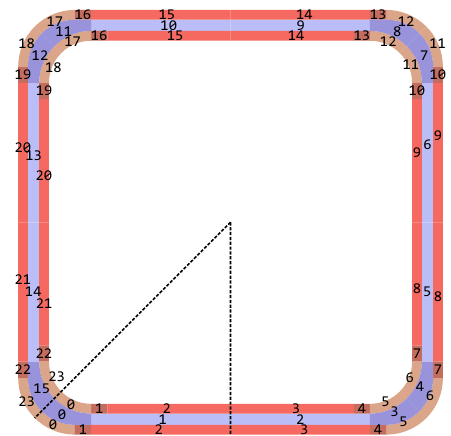
Figure 1. Geometry of the IRT-4M fuel assemblies: standard 8-tube fuel assembly (top) and control 6-tube fuel assembly (bottom) [3].